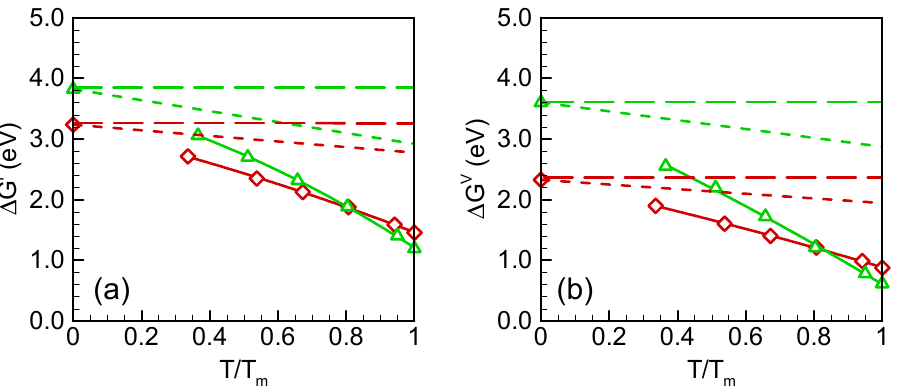
Figure 3. Formation free energies as functions of temperature for ( a ) self-interstitial and ( b ) vacancy.